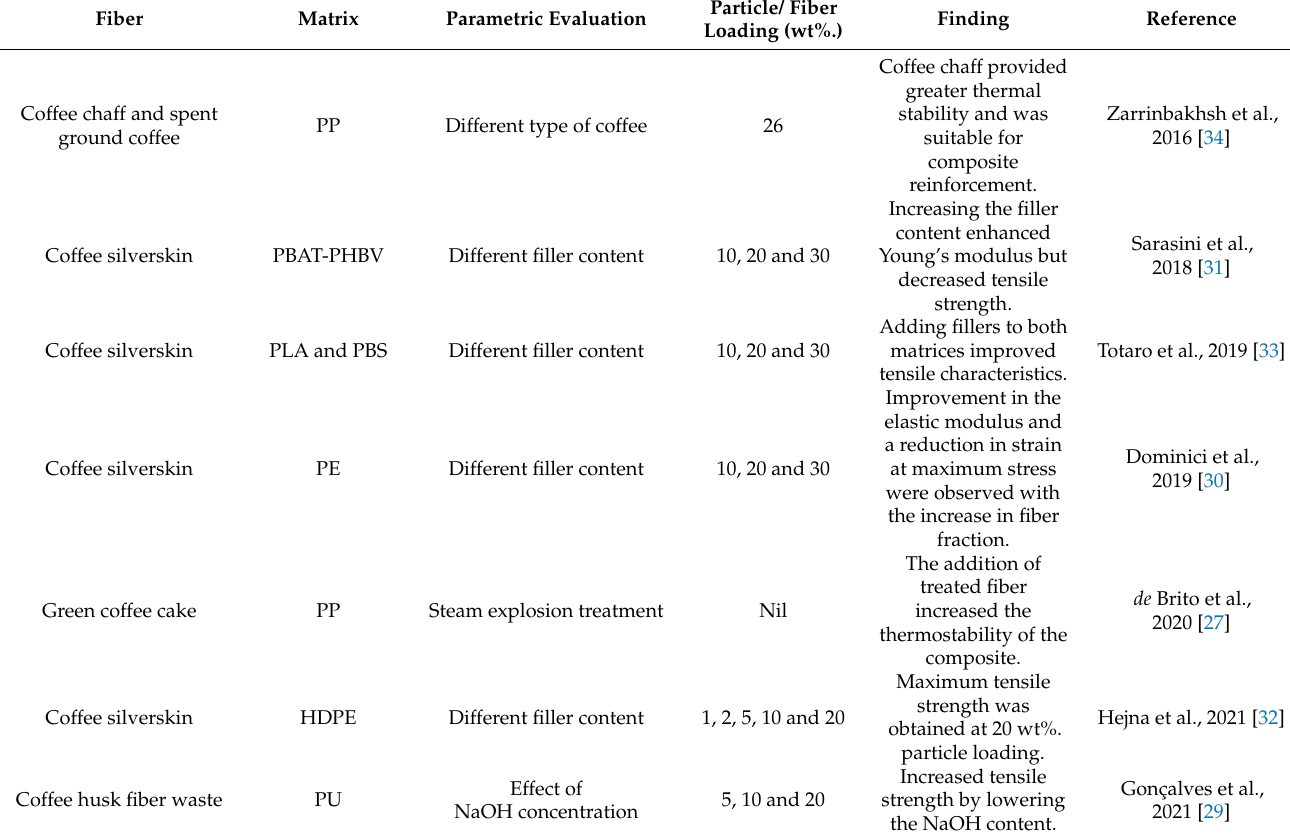
Table 1. Previous reported work on the mechanical and thermal characteristics of coffee waste- reinforced